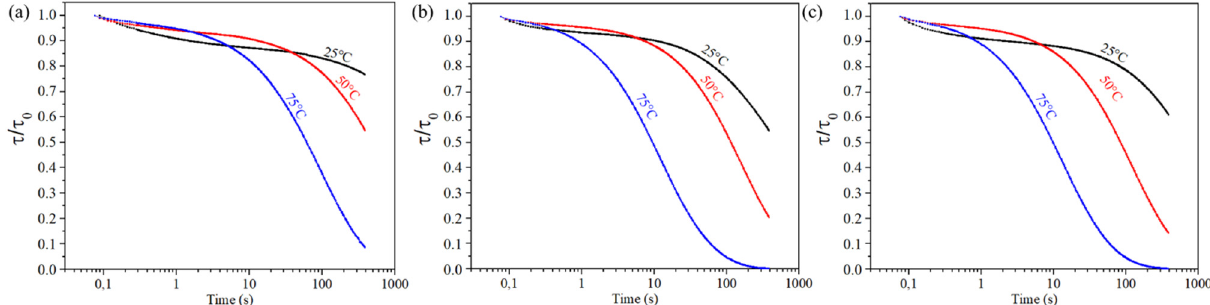
Figure 15. Stress relaxation of ( a ) H0, ( b ) H30 and ( c ) H50 films at 25 °C (black), 50 °C (red) and 75 °C (blue).